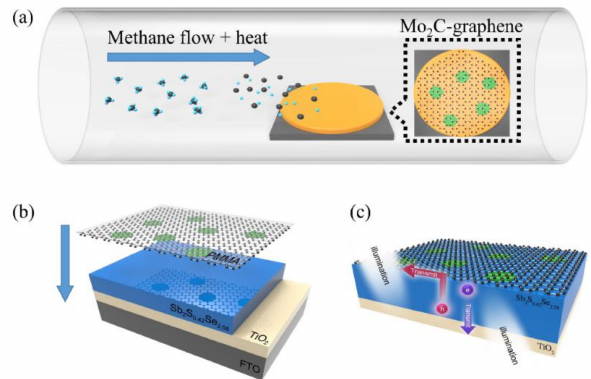
Figure 1. The schematic diagrams of Mo 2 C crystal growth and the novel Mo 2 C—Gr/Sb 2 S 0.42 Se 2.58 / TiO 2 /FTO vertical heterostructure photodetector. ( a ) Schematic diagram of the chemical vapor deposition (CVD) method to grown Mo 2 C—graphene. ( b ) The schematic diagram of the transfer of the Mo 2 C—Gr layer. ( c ) The schematic diagram of the self-driven two-sided